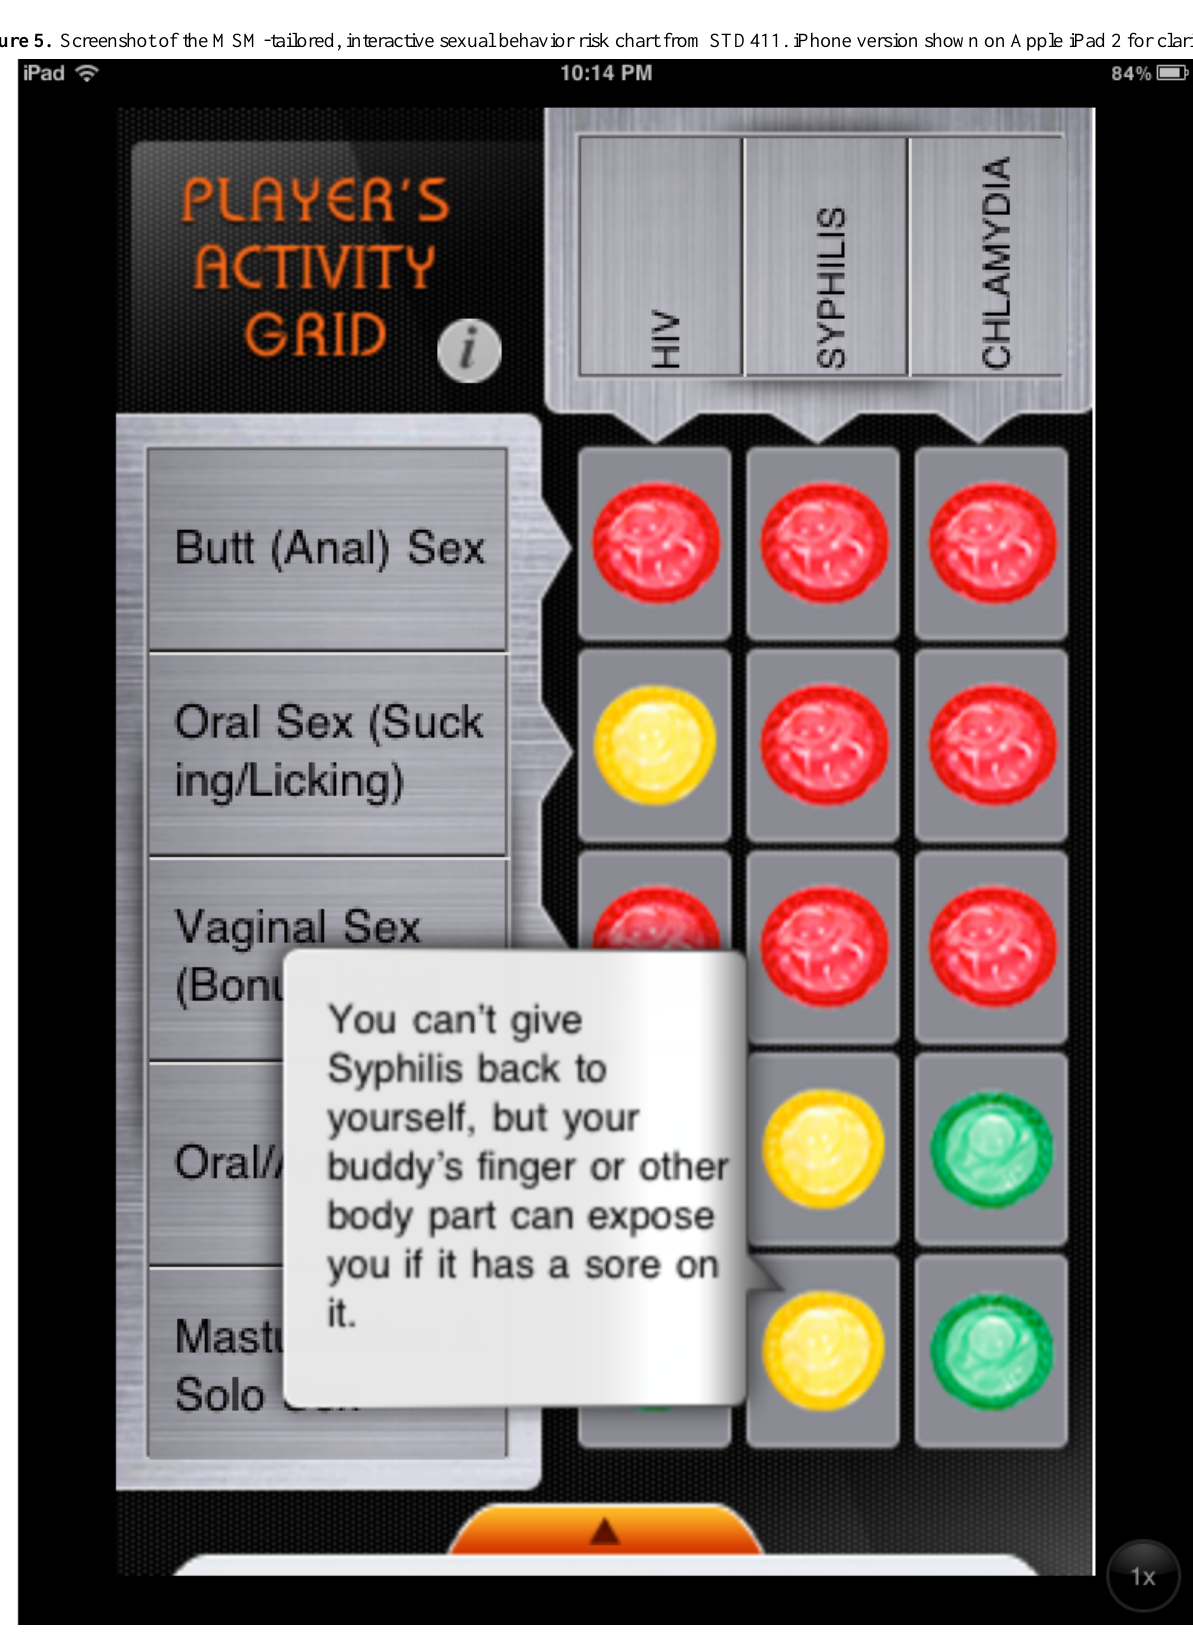
Figure 5. Screenshot of the MSM-tailored, interactive sexual behavior risk chart from STD411. iPhone version shown on Apple iPad 2 for